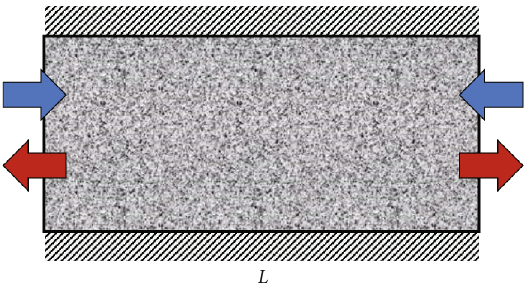
Figure 7: One-dimensional water imbibition model (the blue arrows represent the water fl ow, and the red arrows represent the oil fl